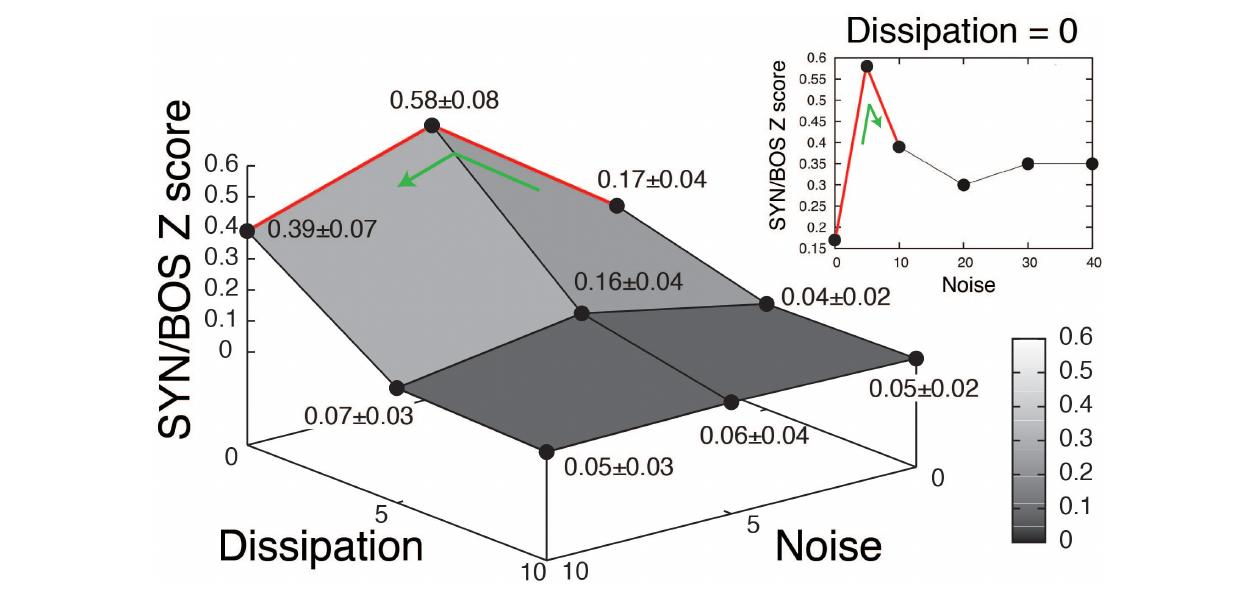
FIGURE 4 | Quantification of neural response to synthetic songs variants. Grouped data of 30 recorded neurons in HVC selective to the bird’s own song (BOS). The synthetic songs (SYN) variants changing the level of noise in β and dissipation of the resonator representing the OEC are organized as in the grid shown in Figure 3 . The Z scores of SYN, were normalized to the BOS Z score, and averages across neurons were reported as means of normalized responses ± SEM. The inset (Dissipation = 0) shows the neural responses to high levels of noise with full presence of the OEC resonator. Adapted from Amador et al.